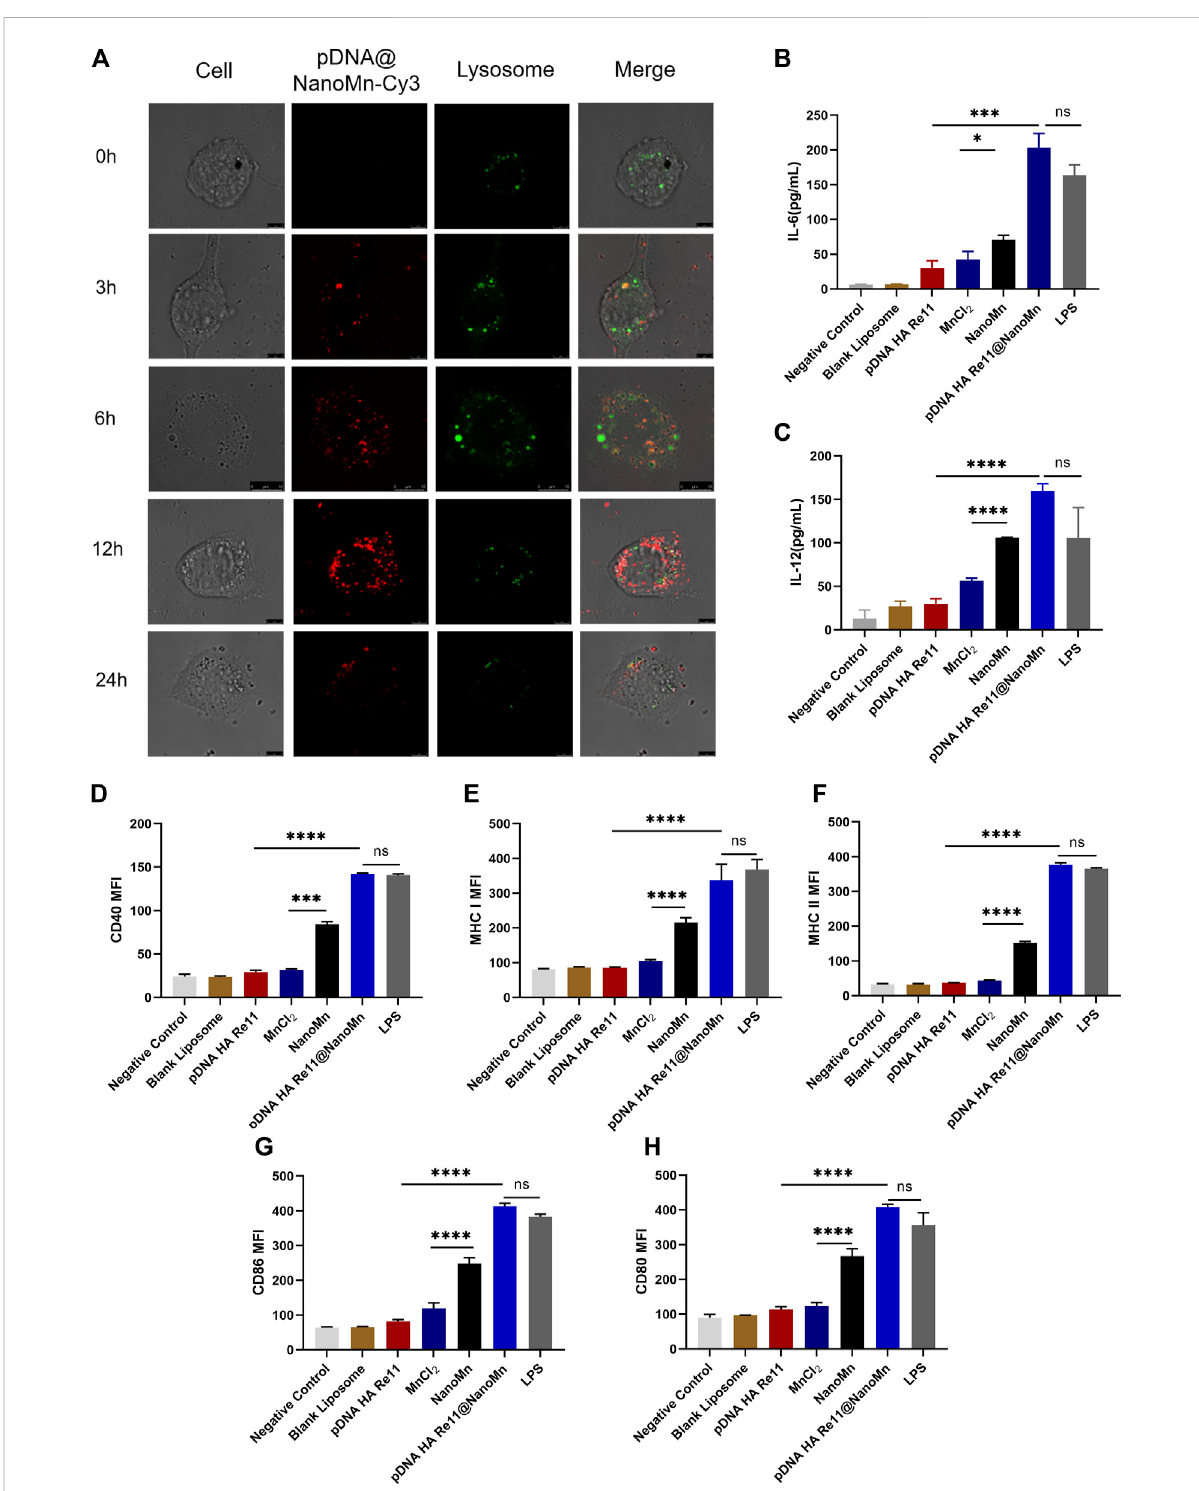
FIGURE 3 (A) In vitro cellular uptake assay. Intracellular distribution images of DC2.4 cells incubated with Cy3-labeled pDNA HA Re11@NanoMn for 24 h, respectively. (B,C) .Different preparations stimulated dendritic cells to release cytokines IL-6 (B) and IL-12 (C) levels. d-h. Effects of different preparations on dendritic cell activation. Dendritic cell surface CD40 (D) MHC I (E) , MHC II (F) CD86 (G) and CD80 (H) expression